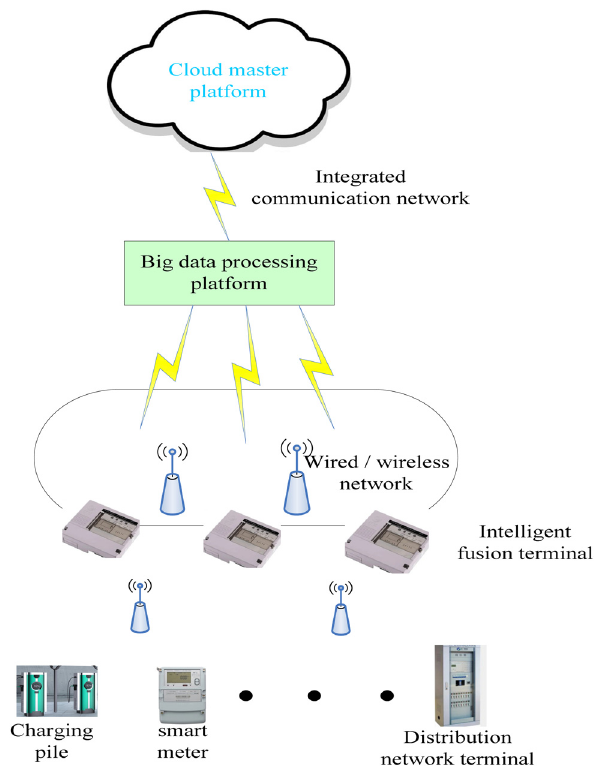
Figure 6: Grid smart terminal